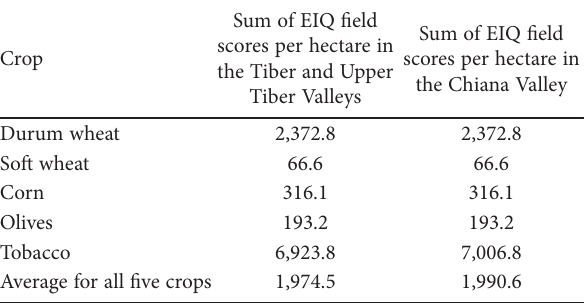
Table 2. TEIQ per hectare in the two areas